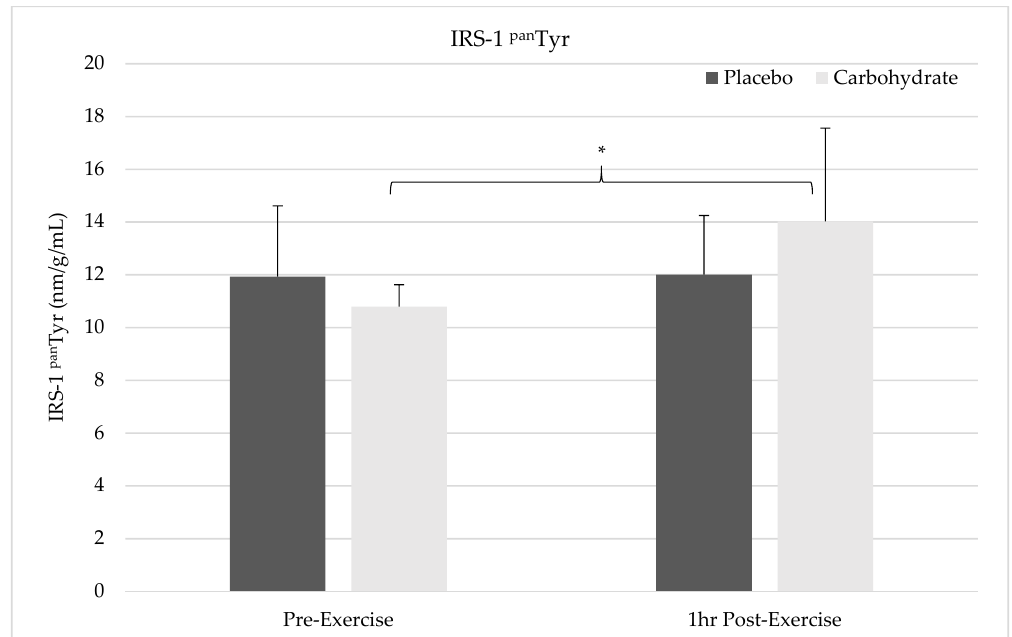
Figure 3. Changes in total amount of activated insulin receptor substrate-1 (IRS-1) pan Tyr for each time point and condition relative to total protein content are illustrated. There was an interaction effect showing a significant increase in IRS-1 phosphorylation in the carbohydrate condition at 1 h post-exercise compared to the placebo (*). No change in IRS-1 ( pan Tyr) was observed for the placebo condition.